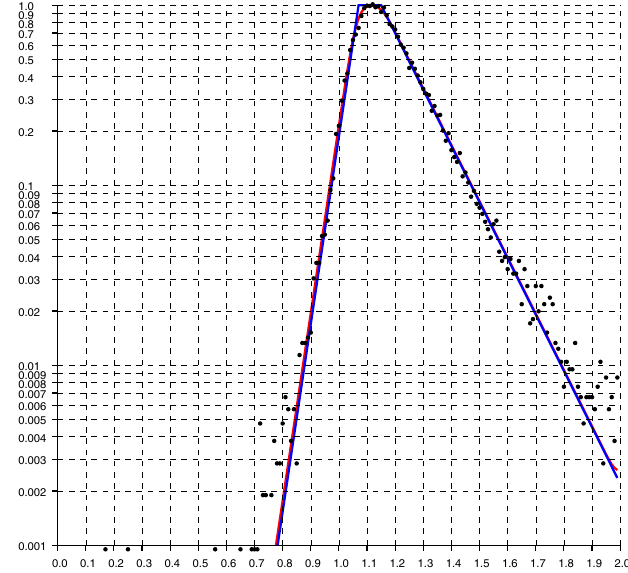
Figure 15. Histogram of the ratio of reported distances to actual distance on a logarithmic scale. The solid blue line is the “double exponential” with flat top parametric